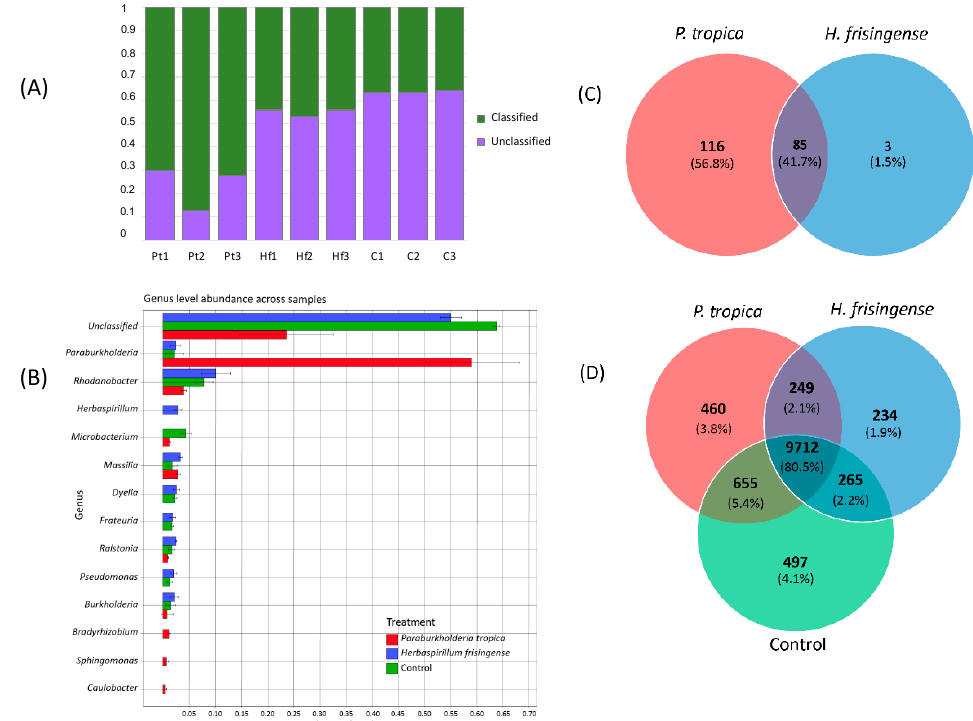
Figure 6. ( A ) Fraction of classified reads per sample. Pt = Paraburkholderia tropica strain IAC/BECa 135, Hf = Herbaspirillum frisingense strain IAC/BECa 152, C = control. ( B ) Abundance across samples of the 10 most abundant genera per treatment. Each bar shows the relative abundance of a genus per treatment. The error bars indicate the standard deviation across samples from the same treatment. ( C ) Comparison of the presence or absence of plant growth-promoting rhizobacteria (PGPR) genes in the P. tropica strain IAC/BECa 135 and H. frisingense strain IAC/BECa 152 genomes. ( D ) Comparison of